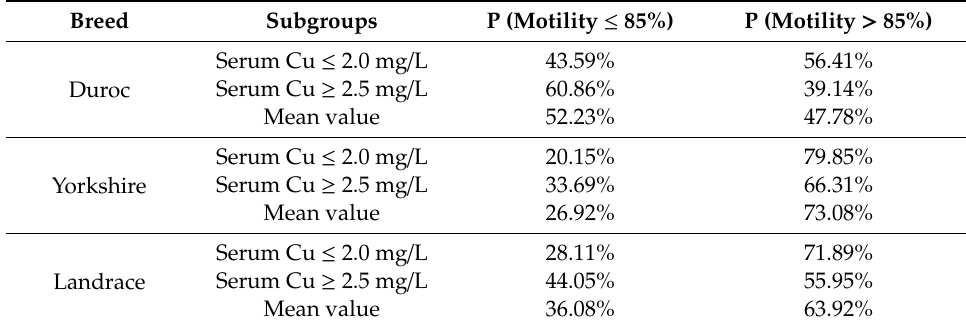
Table 6. Prediction of the occurrence probability of boar sperm motility less than or greater than 85% under di ff erent breeds and serum Cu